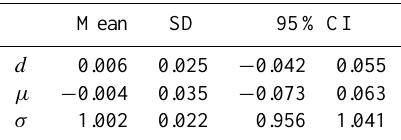
Table 1. Posterior summary statistics for an ARFIMA(0,0,0) process. Results are based on averaging over 100 independent ARFIMA(0,0,0) simulations for the long-memory parameter d , mean µ and noise variance σ